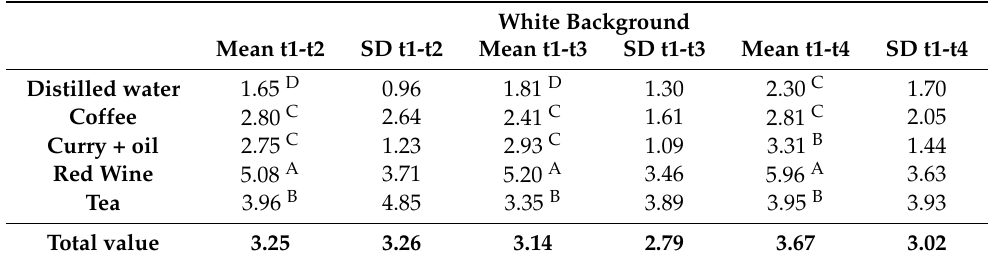
Table 6. Mean and Standard Deviations of CIEDE00 color differences over time according to different staining liquids analyzed over a white background. ABCD rankings are from the highest ( A ) to the lowest staining results using Fisher’s LSD post hoc test at a p -value < 0.01.